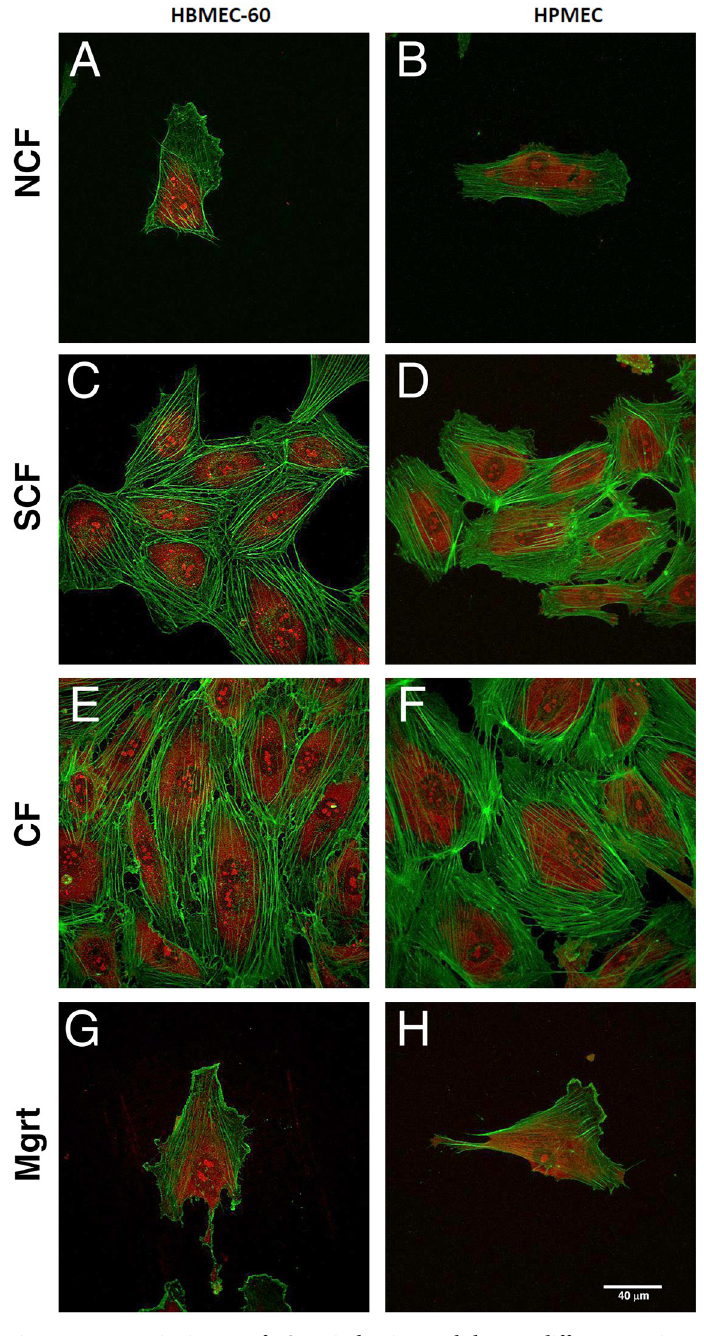
Fig 6. Representative images of EC cortical actin cytoskeleton at different growing states visualized by Phalloidin staining and confocal microscopy. HBMEC-60 (A, C, E and G) and HPMEC (B, D, F and H) cells were cultured in chamber slides until reaching desired growth states (NCF, SCF, CF, Mgrt). Cells were fixed in 2% paraformaldehyde and permeabilized with 0.1% Triton X-100 as described in Materials and Methods. Cellular actin was visualized using Alexa Fluor 647 conjugated Phalloidin (pseudo green) and nuclei counterstained with Propidium Iodide (red). The Z- stacks (42–62 planes per stack) were acquired with 0.2 μ m step size at 60x magnification and Max Intensity images were generated from each stack. Both HBMEC-60 and HPMEC cells at SCF (C and D) and CF (E and F) states revealed denser, thicker and more aligned stress fiber networks, compared to their respective NCF (A and B) and Mgrt (G and H) states. Scale bar in H = 40